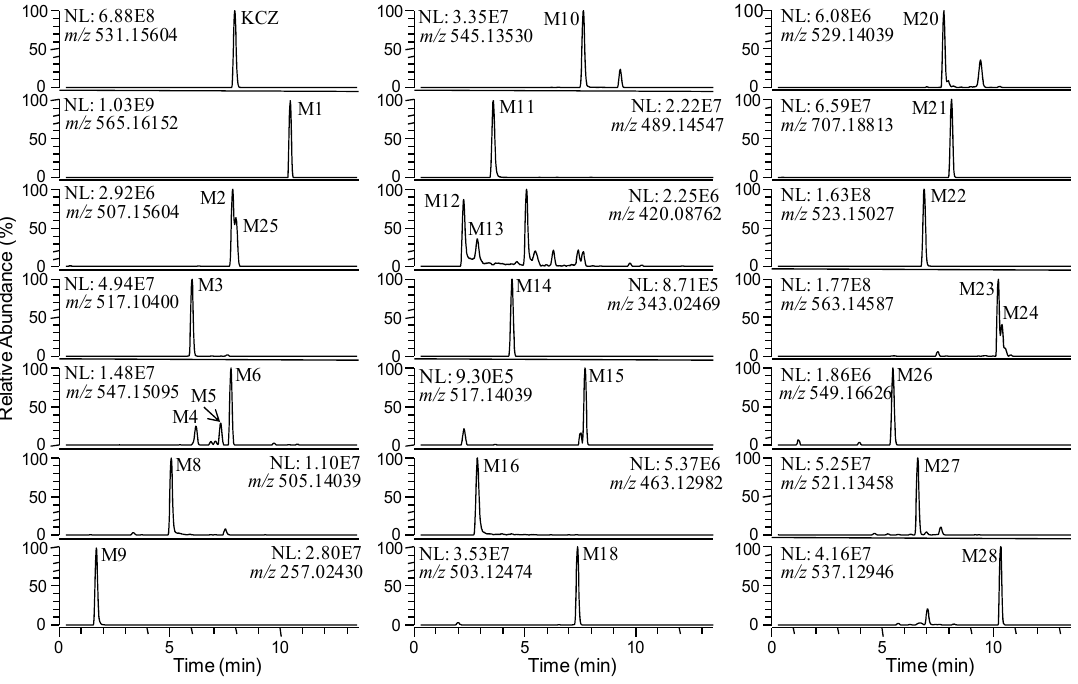
Figure 5. Extracted ion chromatograms of ketoconazole and its metabolites in mouse feces after oral administration of 300 mg/kg ketoconazole.